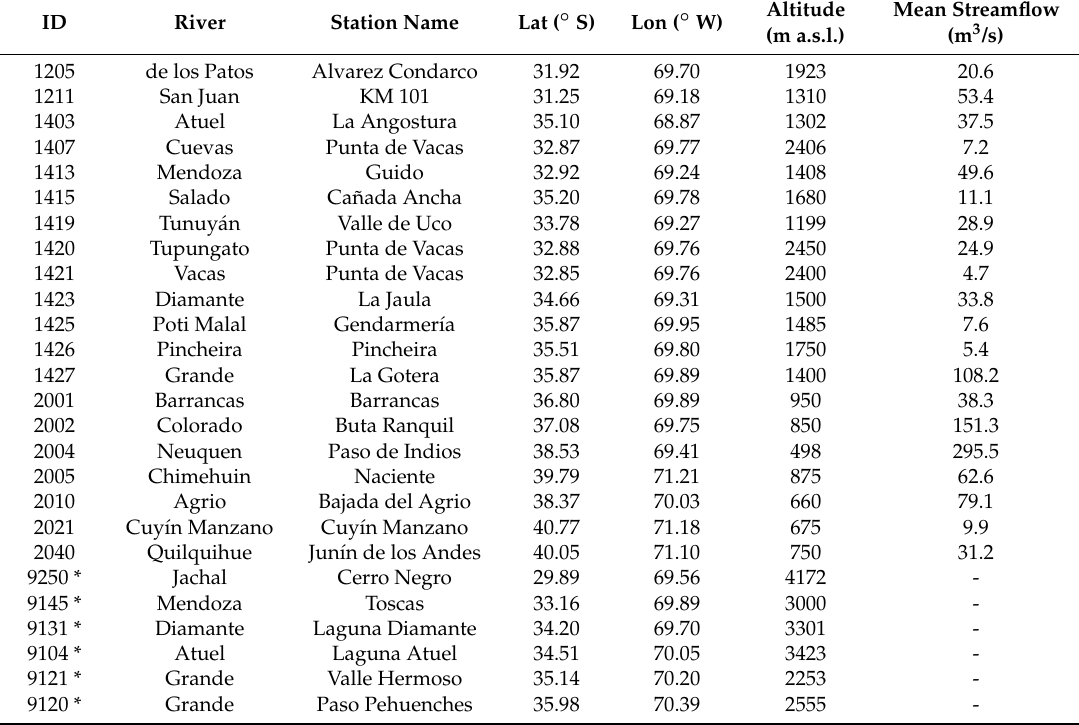
Table 1. Geographical information on selected stations. IDs with an asterisk (*) correspond to snow